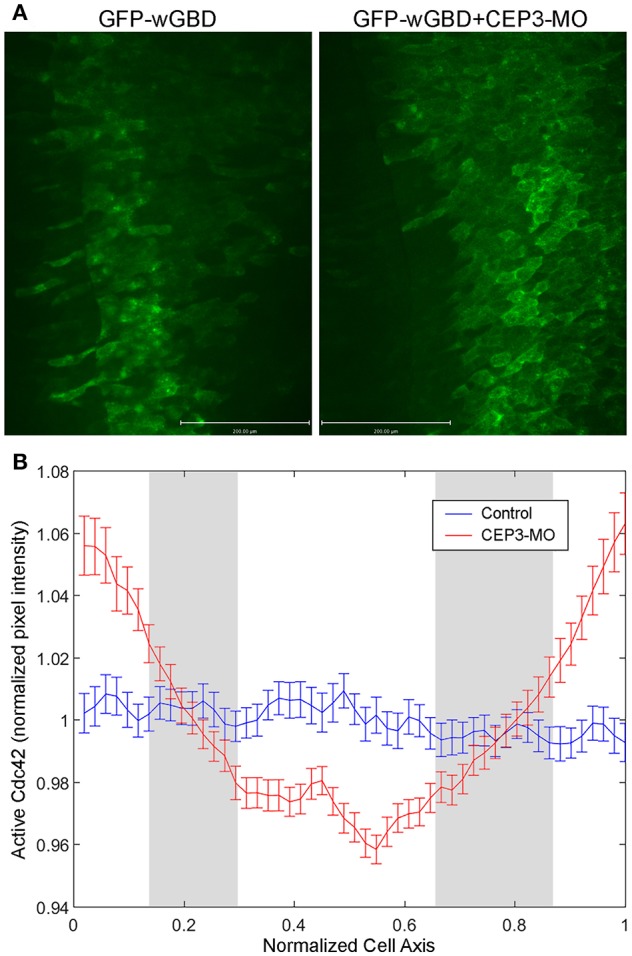
CEP3-MO regulates Cdc42 activity in the developing somite. GFP-wGBD that binds to active Cdc42 was expressed in the paraxial mesoderm alone or together with CEP3-MO. (A) While GFP-wGBD was largely internalized and distributed in a diffused manner in control somitic cells, it was localized to the cell membrane in CEP3-MO-injected cells, reflecting a higher level of Cdc42 activity. (B) An intensity plot of GFP-wGBD across the mediolateral axis of cells was generated. There was a significantly higher level of GFP-wGBD at the cell periphery in CEP3-MO-injected cells and a significantly lower level of GFP-wGBD in the center of CEP3-MO-injected cells. Error bars: standard error of the mean. Student t-test was performed, and the gray area marks places where p > 0.01.